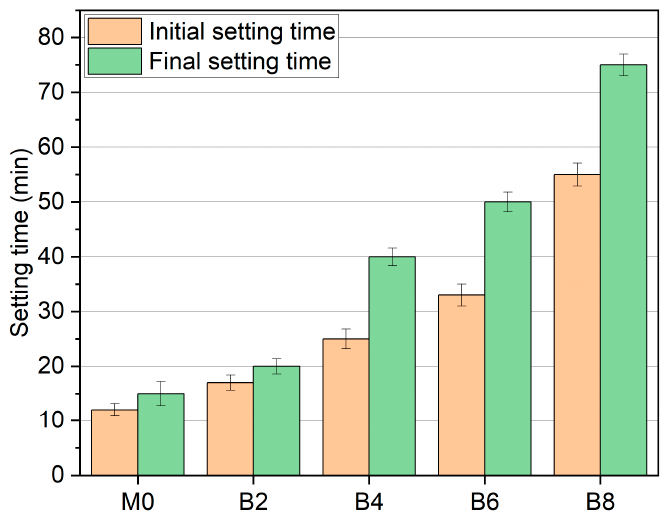
Figure 2. The e ff ect of borax on the se tt ing time of AAS with di ff erent borax dosages. Figure 2. The effect of borax on the setting time of AAS with different borax